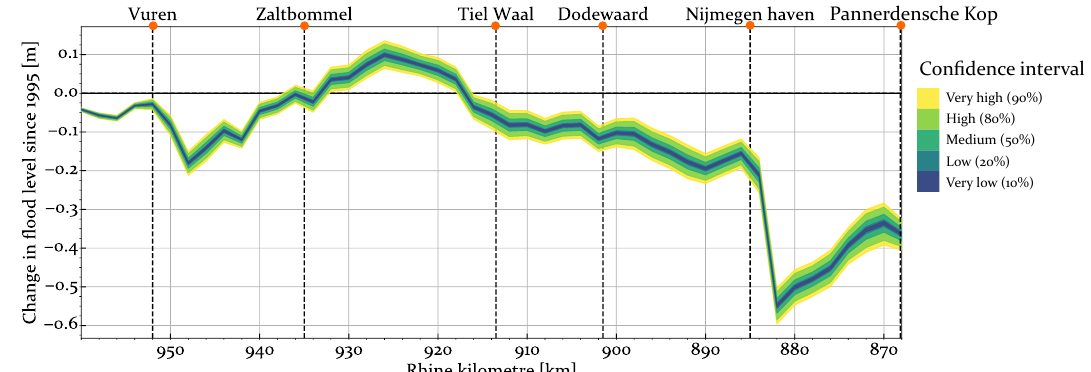
Figure 4. Simulated change in flood water level in 2015 compared to 1995. The location of the water level measurement stations are